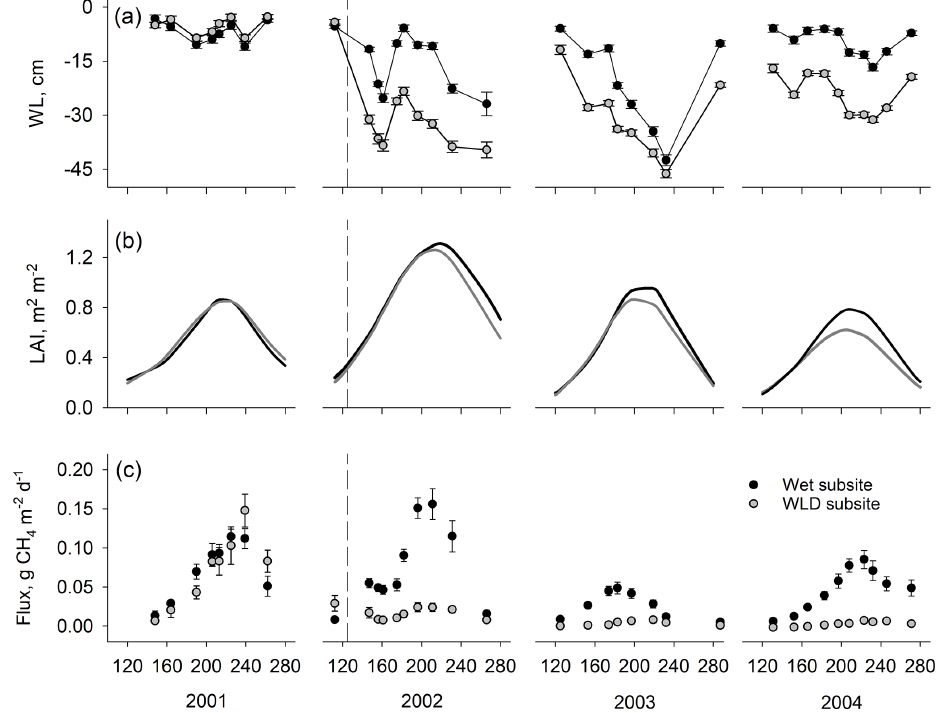
Figure 1. Mean (a) water level (WL), (b) leaf area index (LAI), and (c) CH 4 flux in plots with intact vegetation at wet and water level drawdown (WLD) subsites. Error bars are standard errors of the mean. Units on the x axis give the day of year. The start of the water level drawdown treatment is indicated with the vertical dashed line in 2002. Water level is negative when it is below the moss surface. Positive CH 4 fluxes indicate emission to the